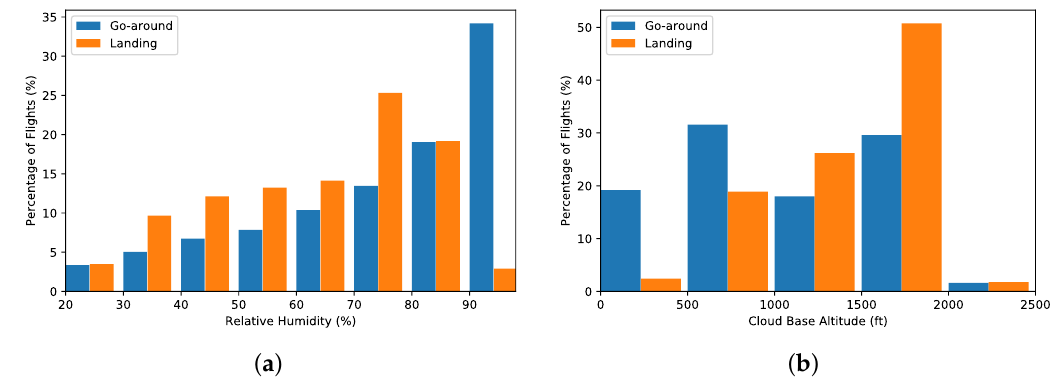
Figure 4. Histograms showing the normalised count of go-around and landings as a function of ( a ) relative humidity and ( b ) cloud base altitude, excluding those situations where the base is greater than 2500 ft. Bars are aligned to the left-hand tick and represent the percentage of flights between one tick and the next. For example, the leftmost bars on ( b ) represent cloud base altitudes between 0–500